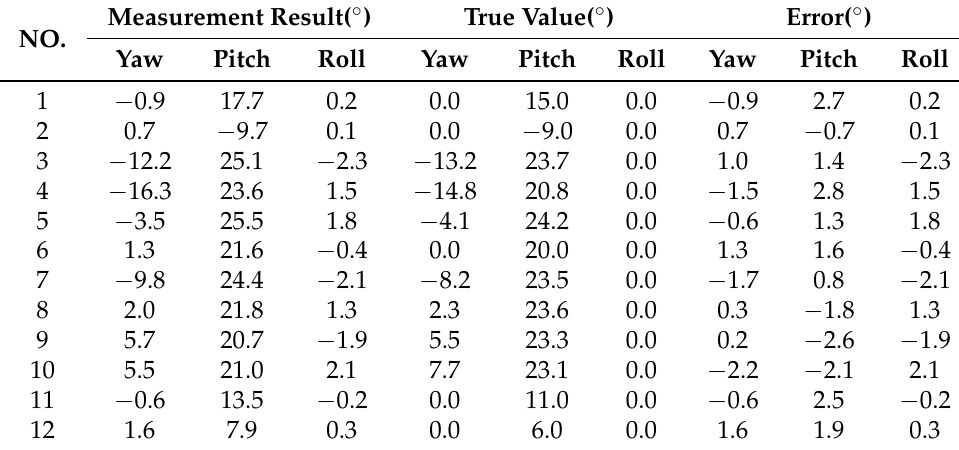
Table 2. Measurement result of attitude